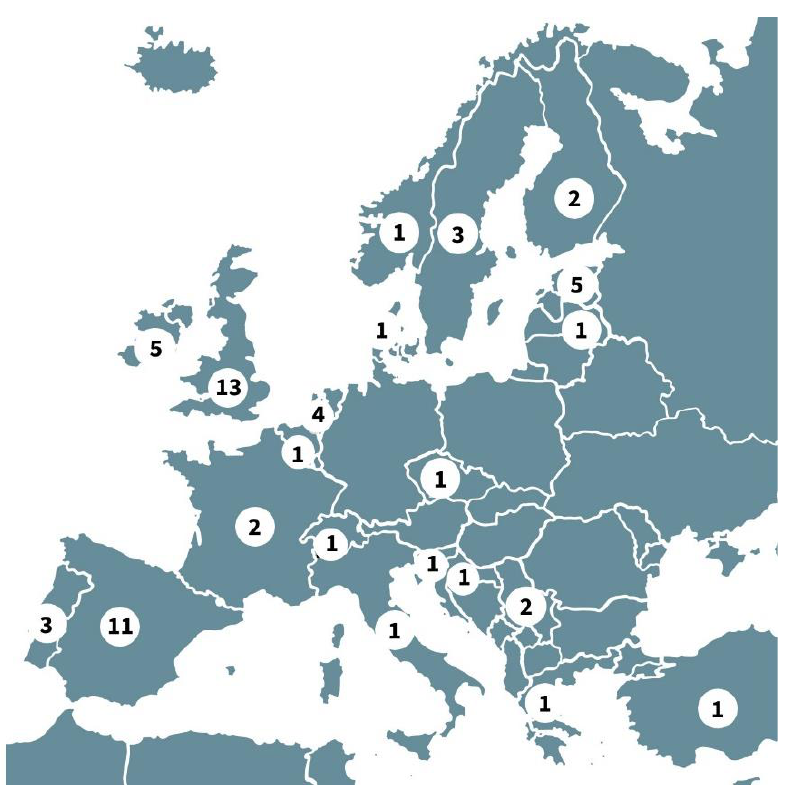
Figure 3. Map of European participants n = number of participants from each European country.